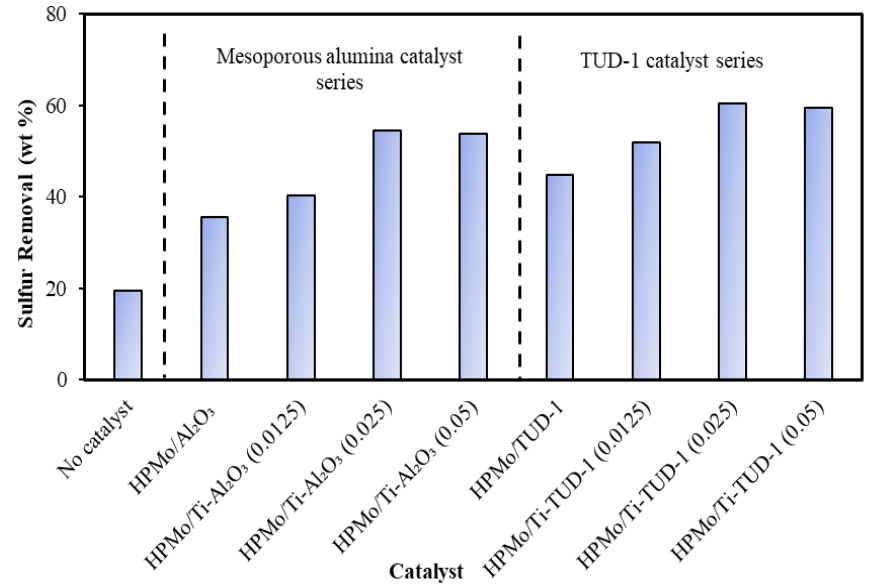
Figure 6. ODS of light gas oil over HPMo/Ti-Al 2 O 3 and HPMo/Ti-TUD-1 catalysts: catalyst/feed = 0.05; T = 70 °C; oxidant = 30% H 2 O 2 ; H 2 O 2 /S = 10; t = 2 h; and stirring rate = 550 rpm.